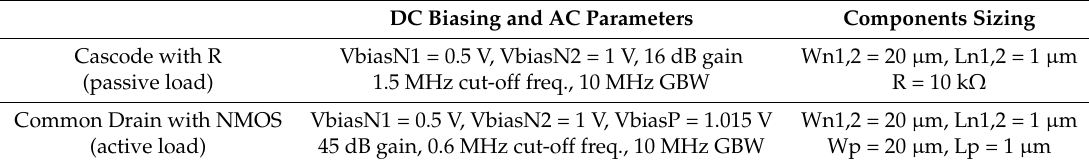
Table 3. DC and AC parameters and Transistor Sizing of the Cascode